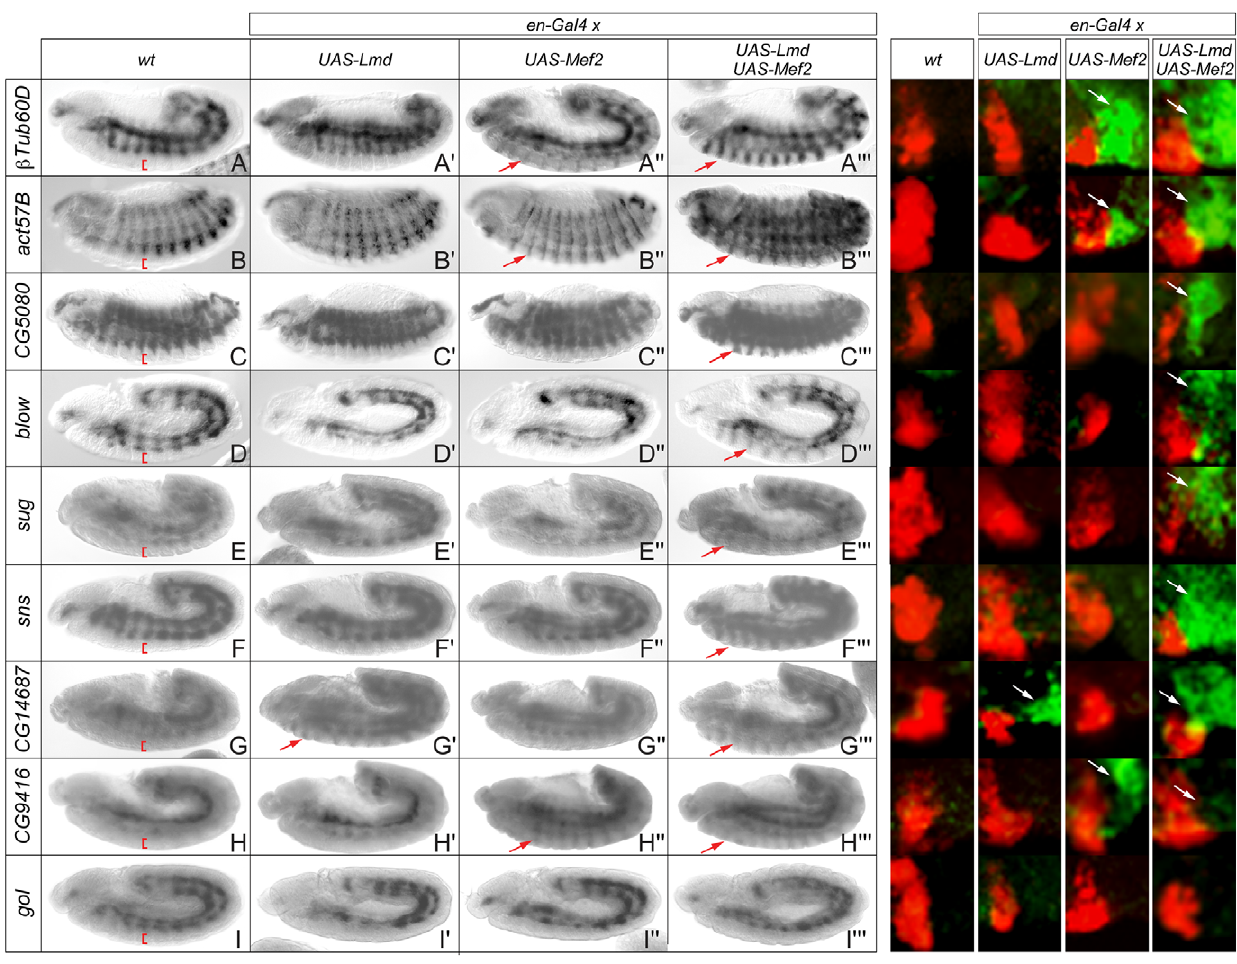
Figure 2. Ectopic expression of Lmd and Mef2 reveals differential regulatory influence on target gene expression. Left hand panels: Colorimetric in situ hybridization (black and white images). (A–I) In situ hybridization of wild-type embryos with probes specific for (A) b Tub60D , (B) act57B , (C) CG5080 , (D) blow , (E) sug , (F) sns , (G) CG14687 , (H) CG9416 and (I) gol , detecting specific expression in the mesoderm. No specific staining was observed in the ectoderm (red brackets). An engrailed-Gal4 driver line was used to ectopically express (A 9 –I 9 ) UAS-Lmd, (A 0 –I 0 ) UAS-Mef2-HA or (A 90 –I 90 ) both UAS-Mef2-HA and UAS-Lmd in ectodermal stripes. Lmd and Mef2 show differential ability to activate ectopic target gene expression (red arrows). Expression of 8 of 9 genes can be induced in the ectoderm when both factors are present (A 90 –H 90 ), while gol expression was never observed in the ectoderm (I 90 ). Right hand panels: Double fluorescent in situ hybridization of the same genotypes with probes specific for the corresponding genes (green) and wingless (red). A high magnification of the ectodermal wingless staining reveals adjacent ectopic staining in the engrailed domain (white arrows), not detected in wild-type embryos. Full embryos are shown in Figure S2.